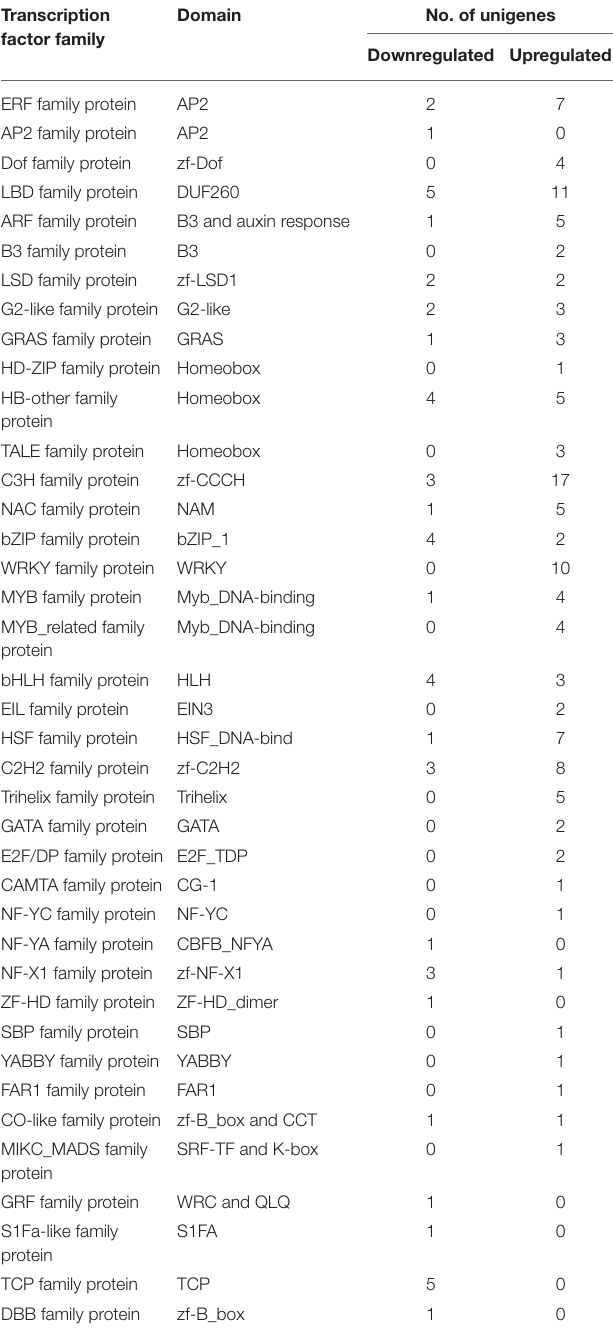
TABLE 3 | Transcription factor families containing downregulated and upregulated unigenes following M. glaucescens shoot organogenesis induction. Transcription factor